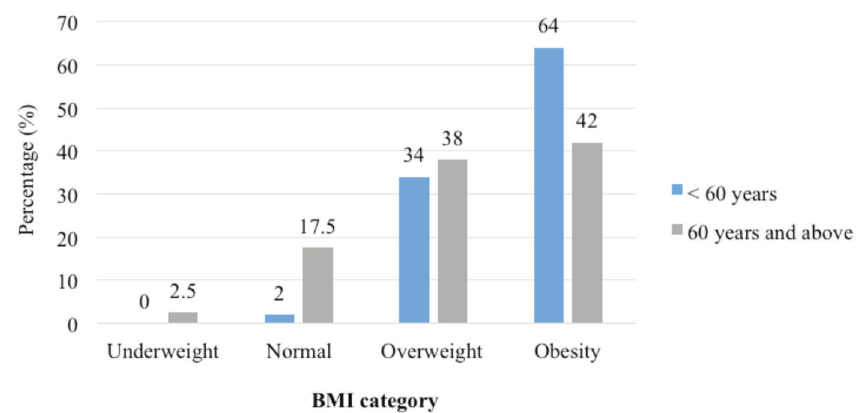
Percentage of BMI classification according to age group (n = 131). Fig. 3: